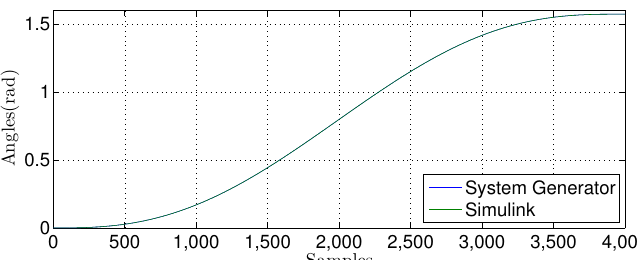
Figure 29. Comparison of the simulation results in Matlab Simulink and system generator for the linear regression technique with M =